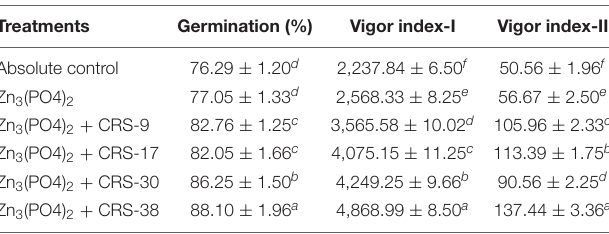
TABLE 2 | Effect of seed inoculation on germination and vigor indices of wheat grown in pots under glasshouse conditions after 30 days of sowing.